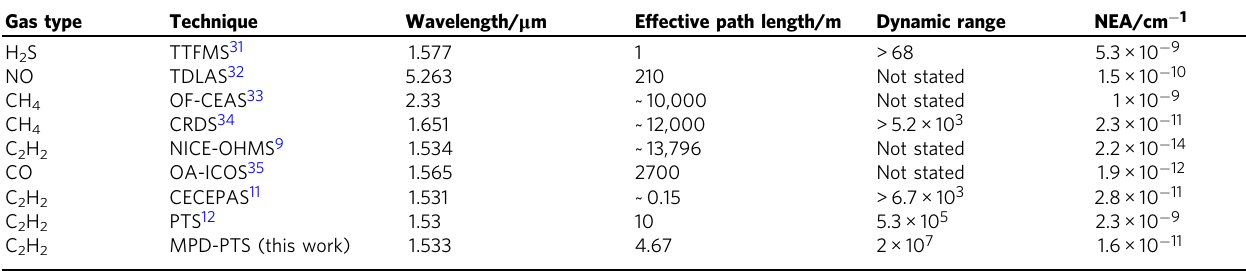
Table 1 Performance of state-of-the-art spectroscopic laser gas